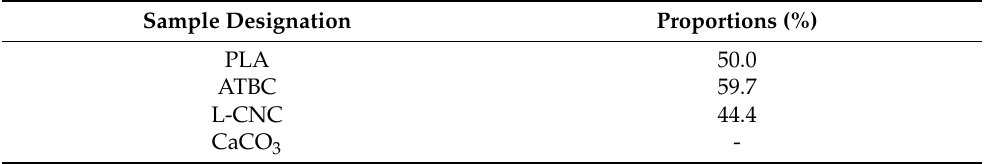
Table 2. The individual proportions of total organic carbon of PLA biocomposite